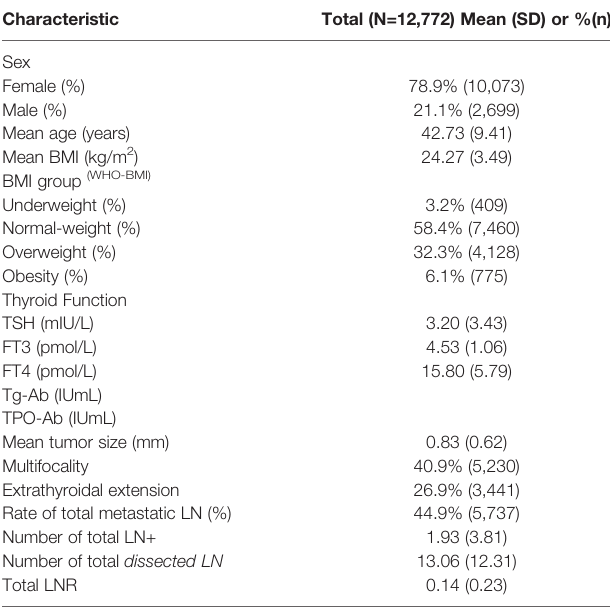
TABLE 1 | Basic demographics and clinical data of patients included in this